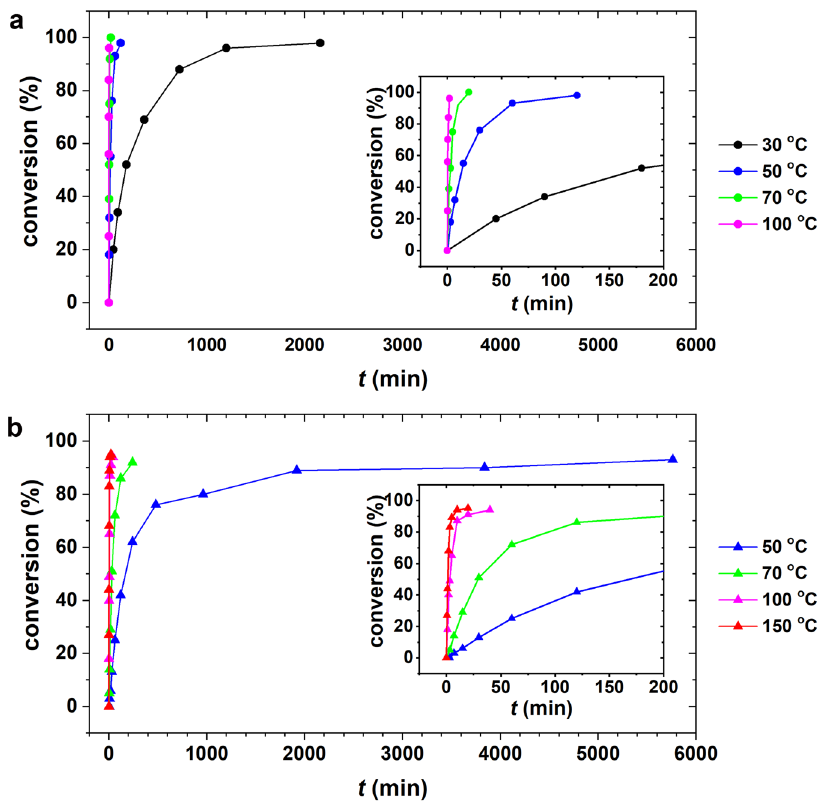
Fig. 2 Temperature-dependent forward and reverse pillar exchanges. a Forward pillar exchange from AP to BE at 30, 50, 70, and 100 °C, respectively. b Reverse pillar exchange from BE to AP at 50, 70, 100, and 150 °C,